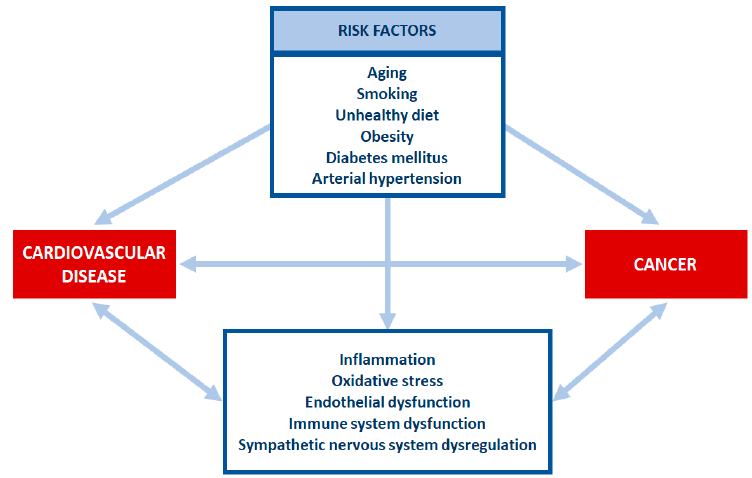
Figure 1. Risk factors and mechanisms shared by cardiovascular disease and cancer.